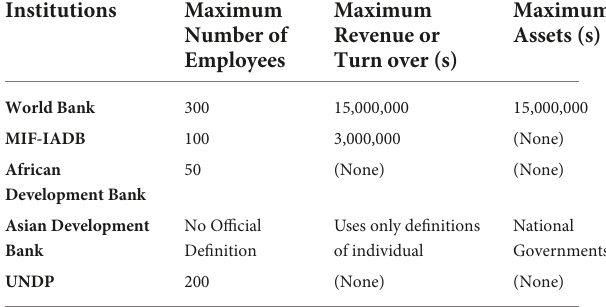
TABLE 1 Small and medium-sized enterprise (SME) definitions used by multilateral institutions.